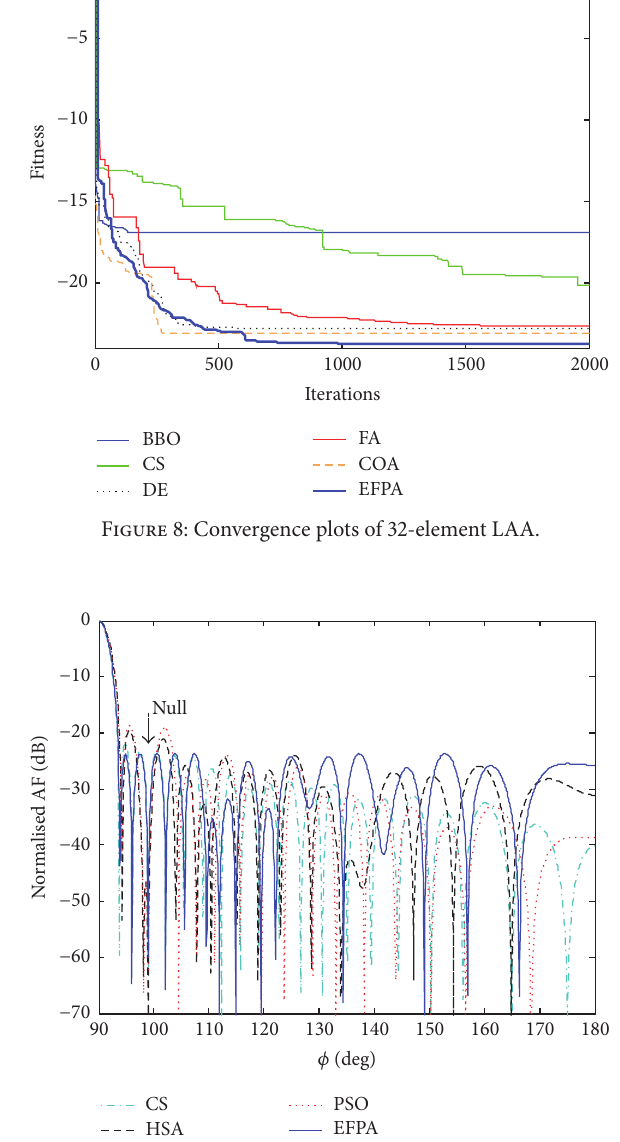
Figure 9: Radiation plot of 32-element EFPA optimized